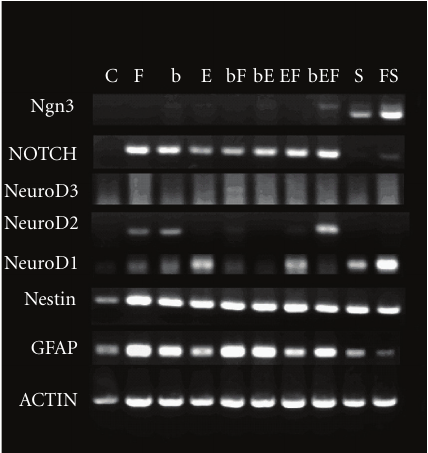
Figure 5: semiquantitive RT-PCR of di ff erent genes in NPCs cultured in di ff erent media. Lane: (C) NPCs in control medium. (F) NPCs in FRIL medium. (b) NPCs in bFGF medium. (E) NPCs in EGF medium. (bF) NPCs in bFGF&FRIL medium. (bE) NPCs in bFGF&EGF medium. (EF) NPCs in EGF&FRIL medium. (bEF) NPCs in bFGF&EGF&FRIL medium. (S) NPCs in serum medium. (FS) NPCs in serum&FRIL medium. Row: ngn3, neurogenin3. NOTCH, notch. NeuroD3, NeuroD3. NeuroD2, NeuroD2. Neu- roD1, NeuroD1. Nestin, nestin. GFAP, GFAP. ACTIN,